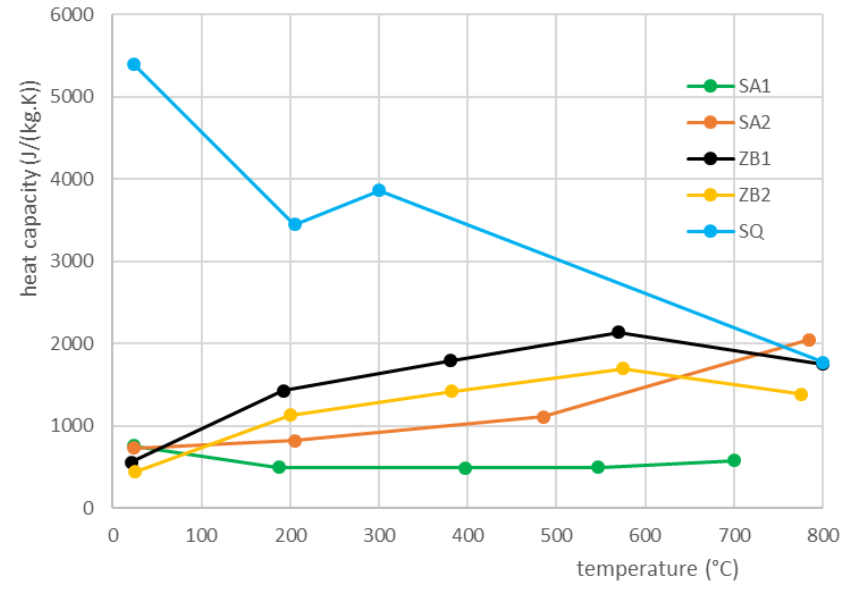
Figure 7. Change in heat capacity depending on the ambient temperature for monitored cementitious